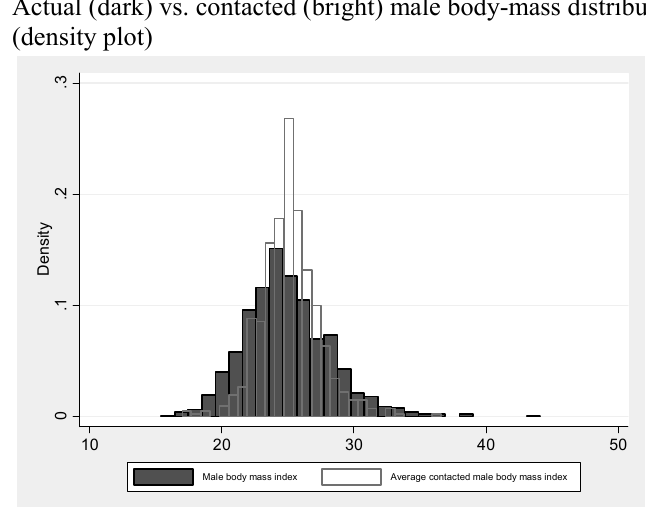
Figure 7 : Actual (dark) vs. contacted (bright) male body-mass distribution (density